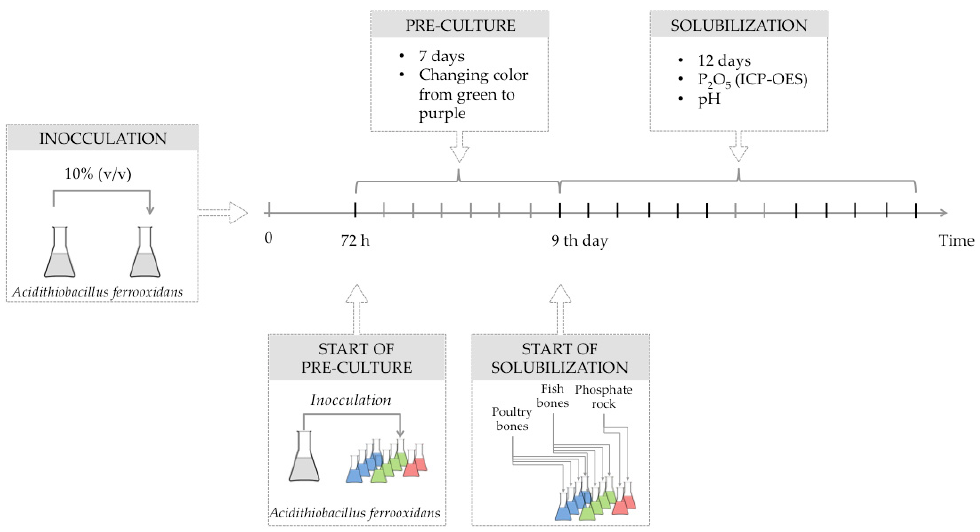
Figure 3. The scheme sampling timing of the experiment.